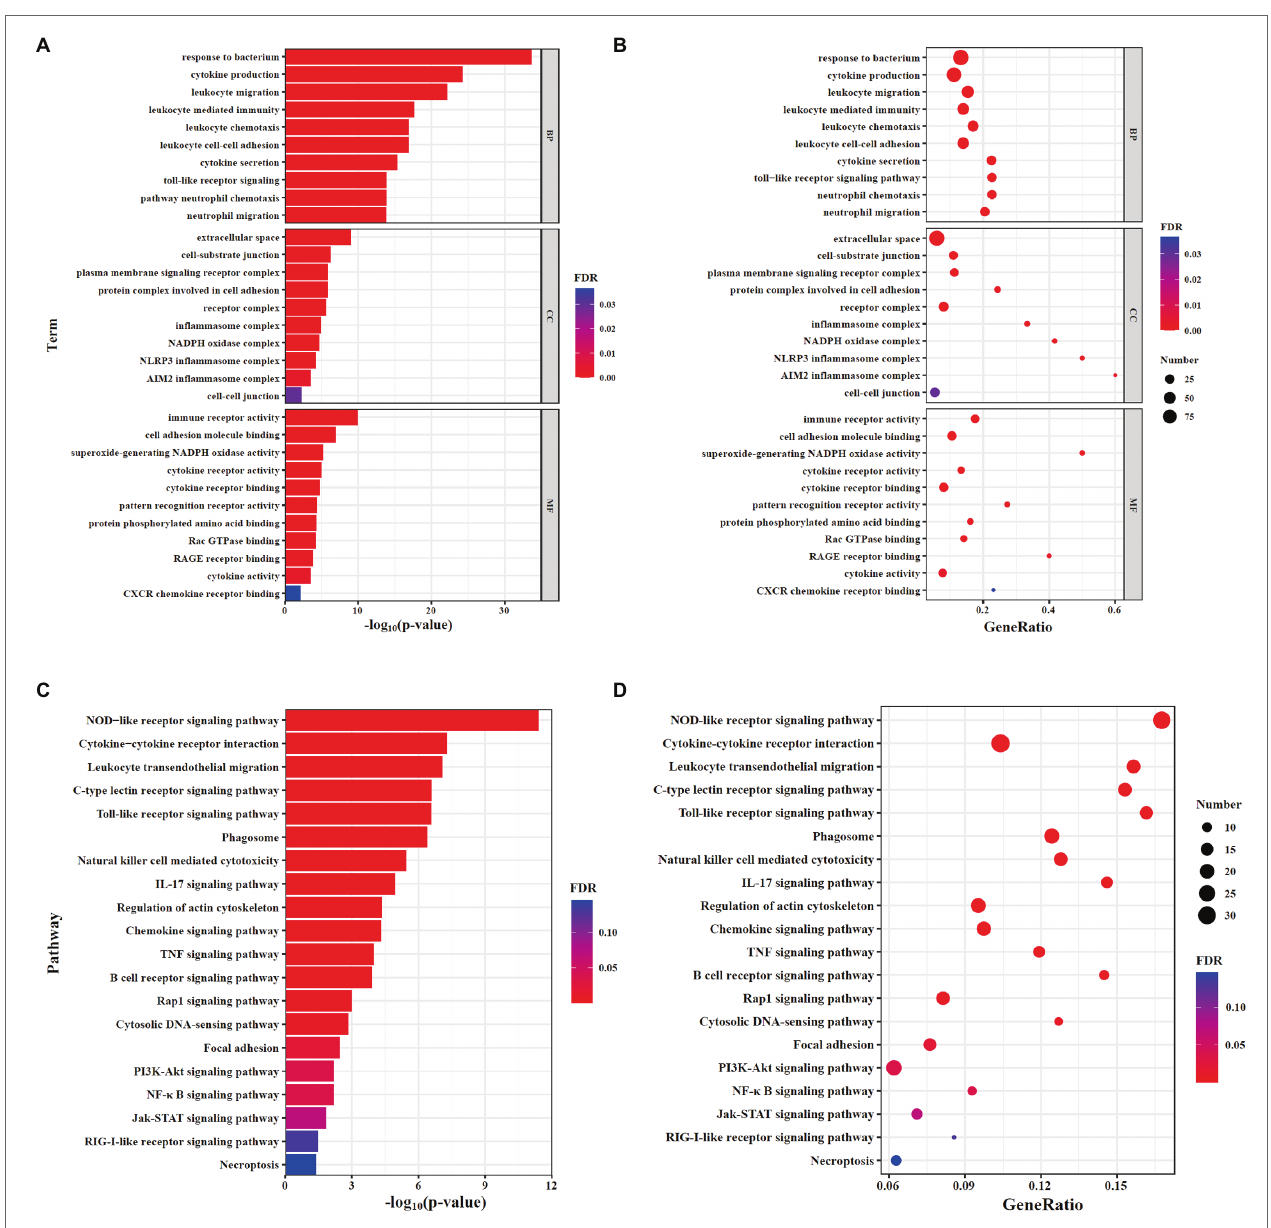
FIGURE 3 | GO and KEGG analysis of DEGs. (A,B) The gene ontology (GO) enrichment analysis of DEGs. (A) Barplot; (B) Dotplot. (C,D) Kyoto encyclopedia of genes and genomes (KEGG) pathway enrichment analysis of DEGs. (C) Barplot; (D) Dotplot. The x-axis shows the -log10(value of p; A,C ) and gene ratio (B,D) of each term, and y-axis shows the GO annotation terms (A,B) and the KEGG pathway terms (C,D)